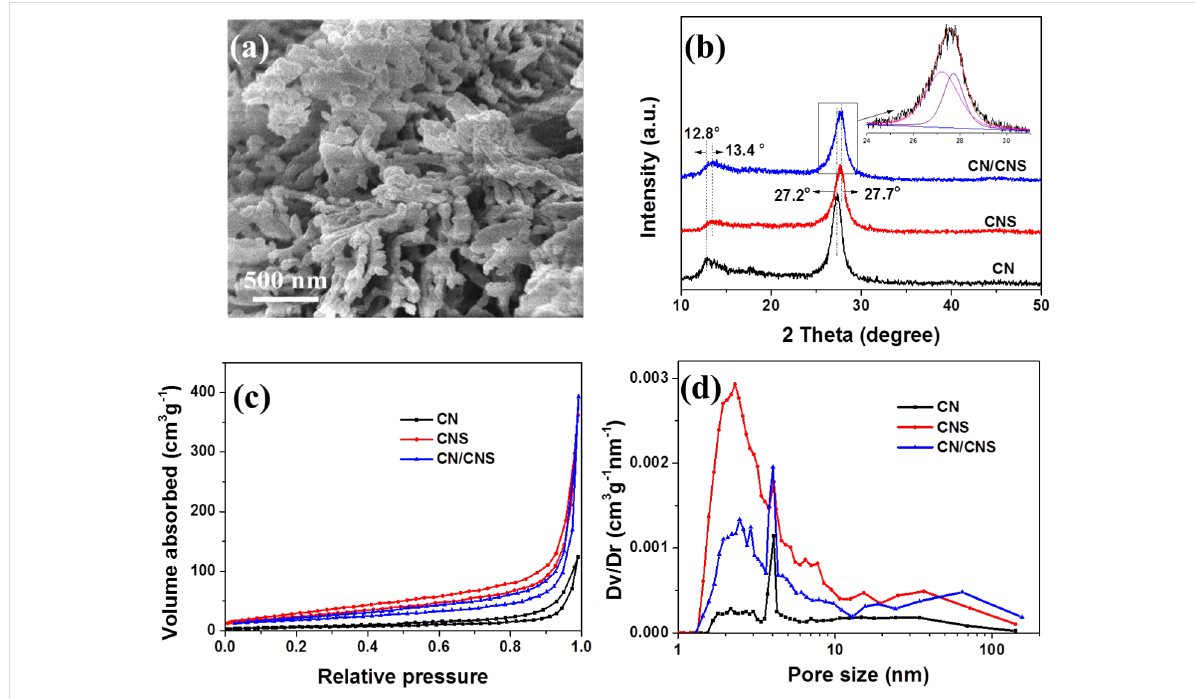
Figure 4: (a) FESEM image of CN/CNS heterostructure, (b) XRD and (c) nitrogen adsorption–desorption isotherms and (d) pore size distribution (insert) of CN, CNS and CN/CNS heterostructure.